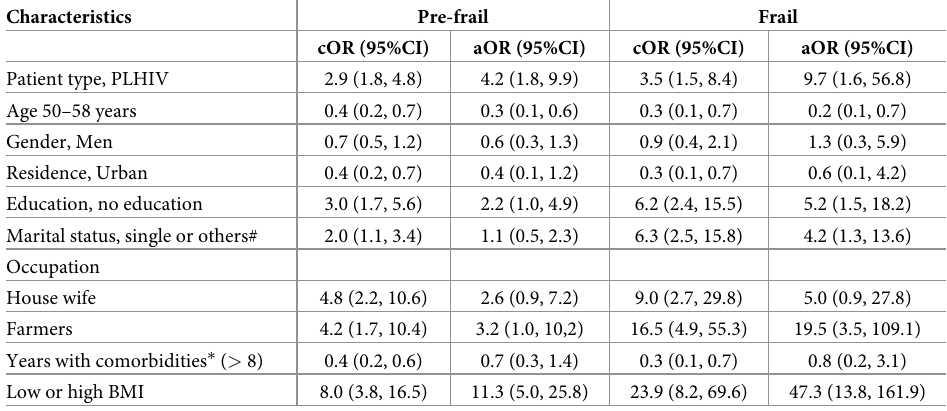
Table 5. Multinomial regression analysis for the risk factors of frailty status.